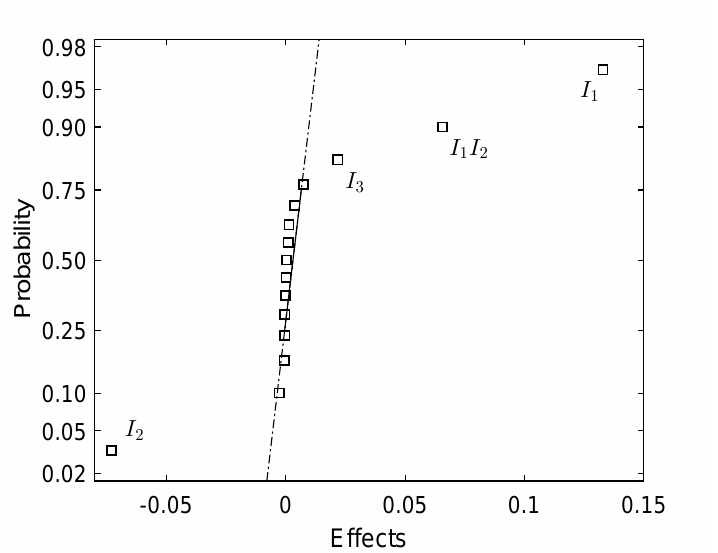
Figure 14. Normal probability plots for stage III showing effects on pressure